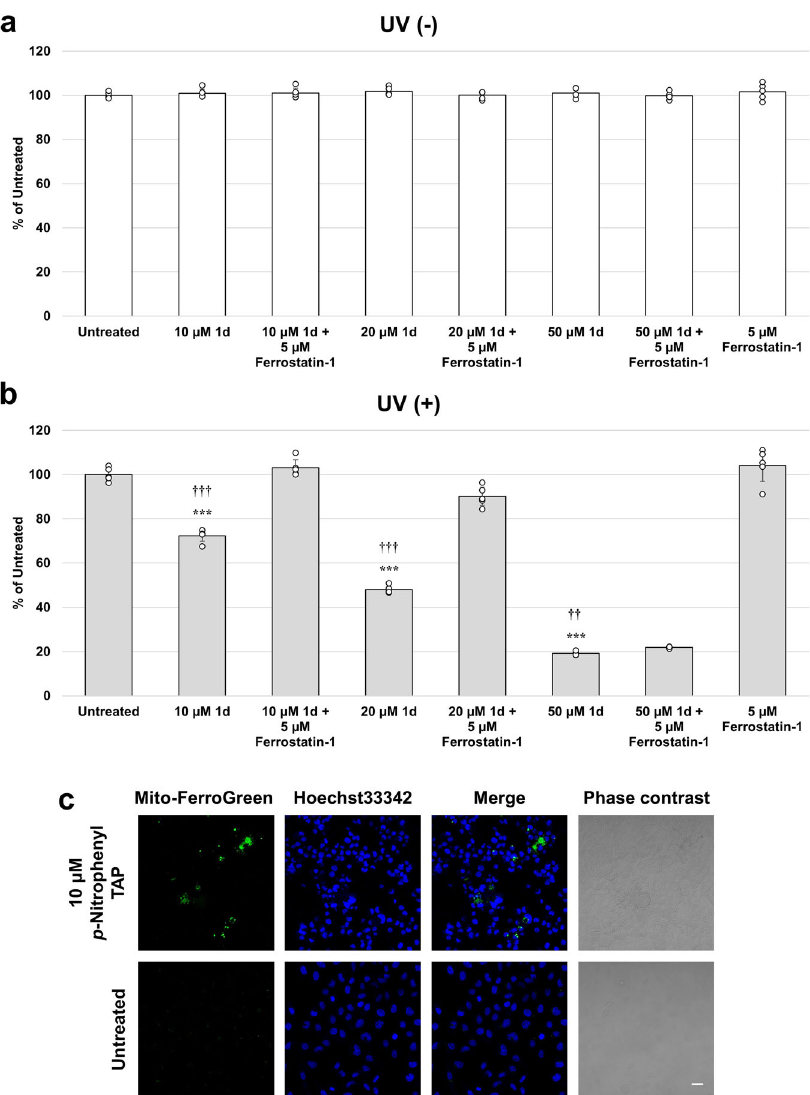
Fig. 8 Detection of ferroptosis in 1d after UV irradiation. a HeLa cells were cultured with 10, 20 μ M and 50 µ M of 1d for 1 h with or without 5 µ M Ferrostatin-1 (Ferroptosis inhibitor), and then the cells were analyzed by WST8 assay. b HeLa cells were cultured with 10, 20 μ M and 50 µ M of 1d for 1 h with or without 5 µ M Ferrostatin-1 (Ferroptosis inhibitor), and then the cells were analyzed by WST8 assay with UV irradiation. c HeLa cells were cultured with 10 µ M of 1d and 5 µ M of Mito-FerroGreen for 1 h, and treated with UV irradiation. After irradiation, the cells were perfused and stained Hoechst33342 (Blue), and observed by confocal microscopy. Scale bar = 50 μ m. *** P <0.001 (vs Untreated), †† P <0.01, ††† P <0.01 (vs with Ferrostatin-1) N = 5 biologically independent samples. The error bars represent the standard deviation of the